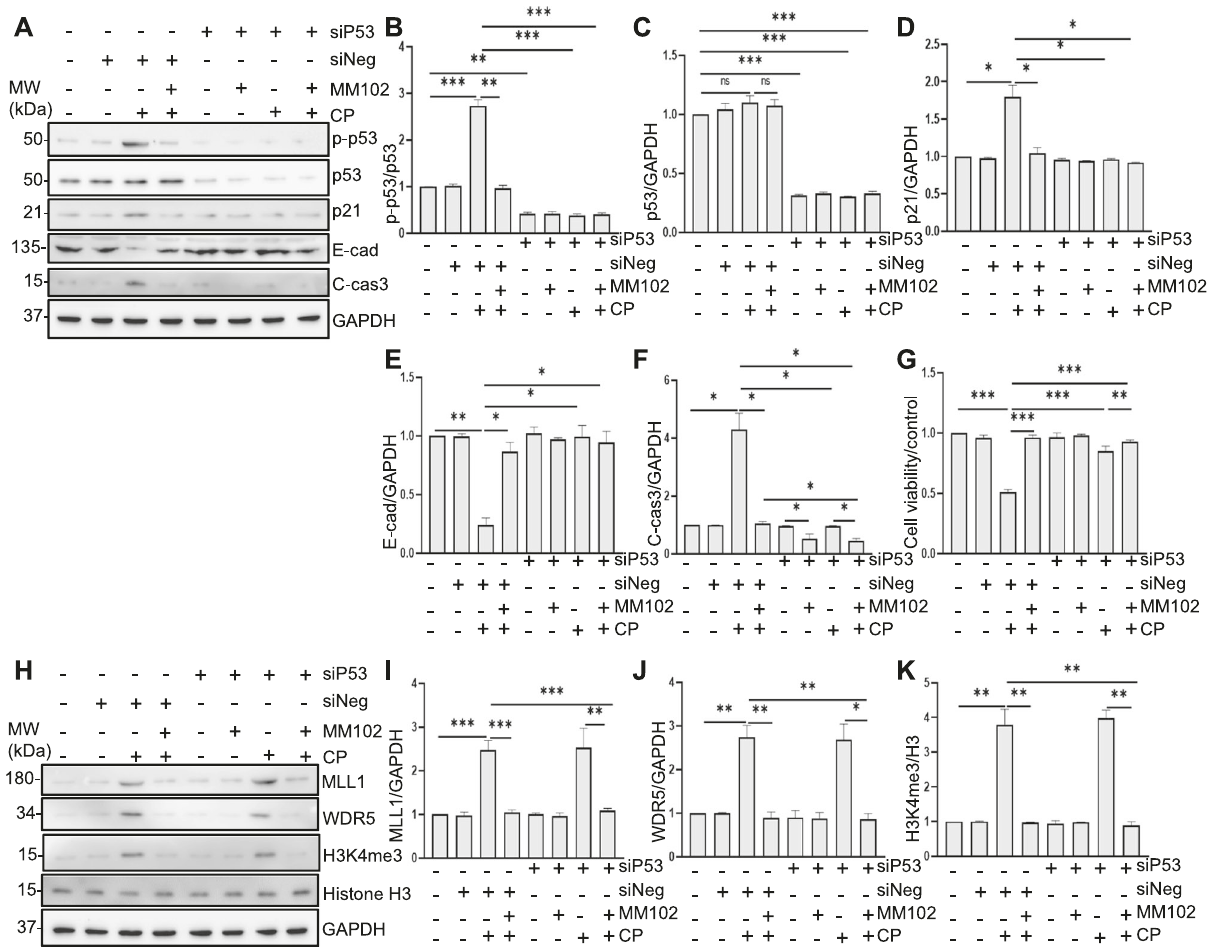
Fig. 6 Knockdown of p53 with silence RNA (siRNA) diminishes cisplatin (CP)-induced apoptosis along with preservation of E-cadherin (E- cad) levels in murine renal proximal tubular epithelial cells (RPTCs). RPTCs were transfected with siRNA targeting p53 or negative siRNA (siNeg) and treated with MM102 (50 μ M) for 1 h and then exposed to CP (20 μ M) for an additional 24 h. Cell lysates were prepared and subjected to immunoblot analysis with antibodies against phospho-p53 (p-p53), p53, p21, cleaved caspase3 (C-cas3), E-cad ( A ), and MLL1, WDR5, H3K4me3, and histone H3 ( H ). p-p53 ( B ) was normalized with p53, p53 ( C ), p21 ( D ), E-cad ( F ), and C-cas3 ( G ) were normalized with GAPDH. MLL1 ( I ) and WDR5 ( J ) were normalized with GAPDH, respectively; H3K4me3 ( K ) was normalized with histone H3. Signal